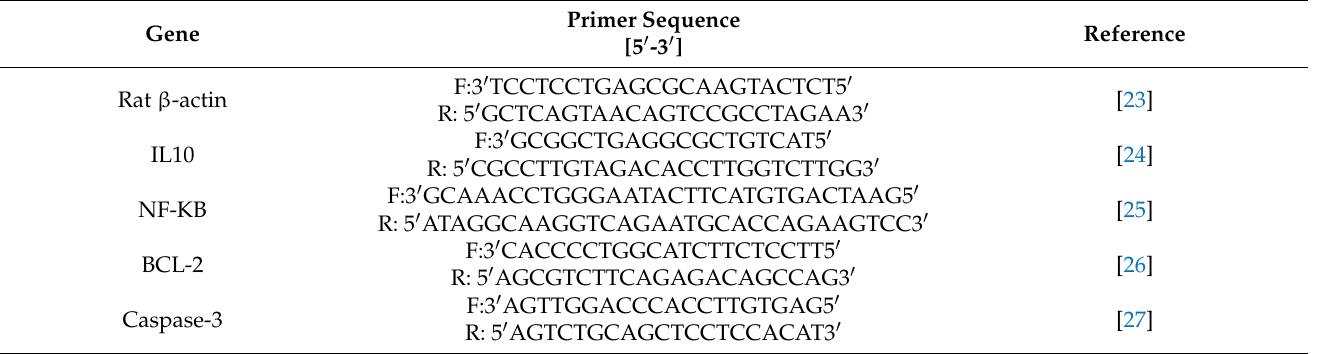
Table 1. Gene expression primer